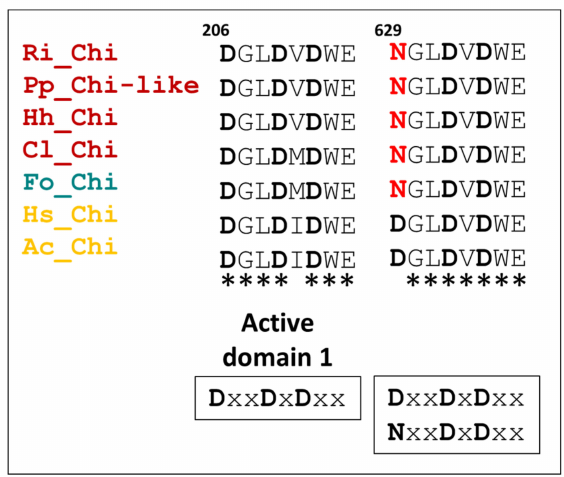
Figure 11. Alignment of chitinases. Chitinase and chitinase-like protein sequences from order Hemiptera (red, R. iracundus , P. plagipennis , Halyomorpha halys , Cimex lectularius ), Thysanoptera (yellow, Frankliniella occidentalis ) and order Hymenoptera (green, Harpegnathos saltator and Apis cerana ) aligned and two active regions were found using interproscan website using R. iracundus chitinase protein sequence. Conserved residues from the active site motifs known for the activity of glycosyl hydrolase family 18 (GH18) indicated with bold. * indicates conserved amino acid